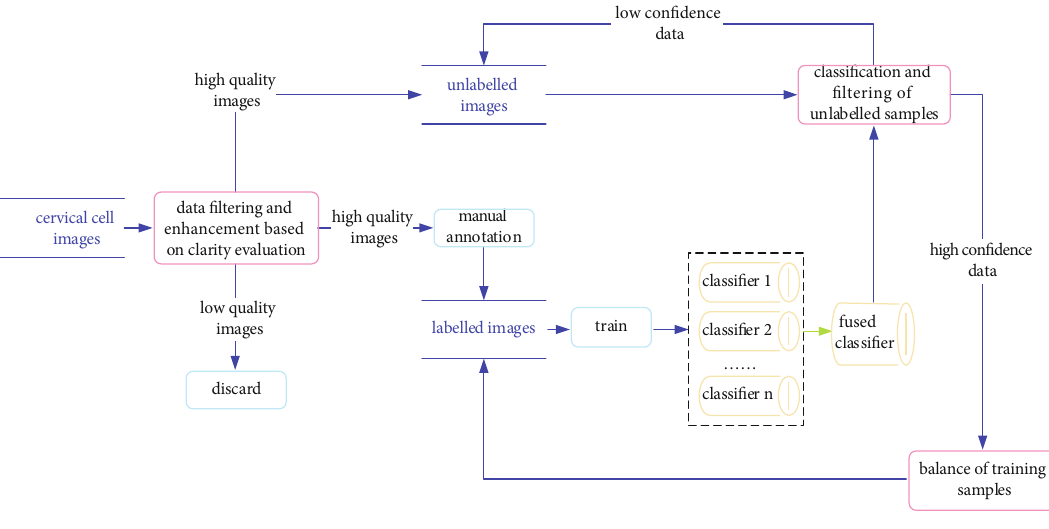
Figure 2: Algorithm data fl ow